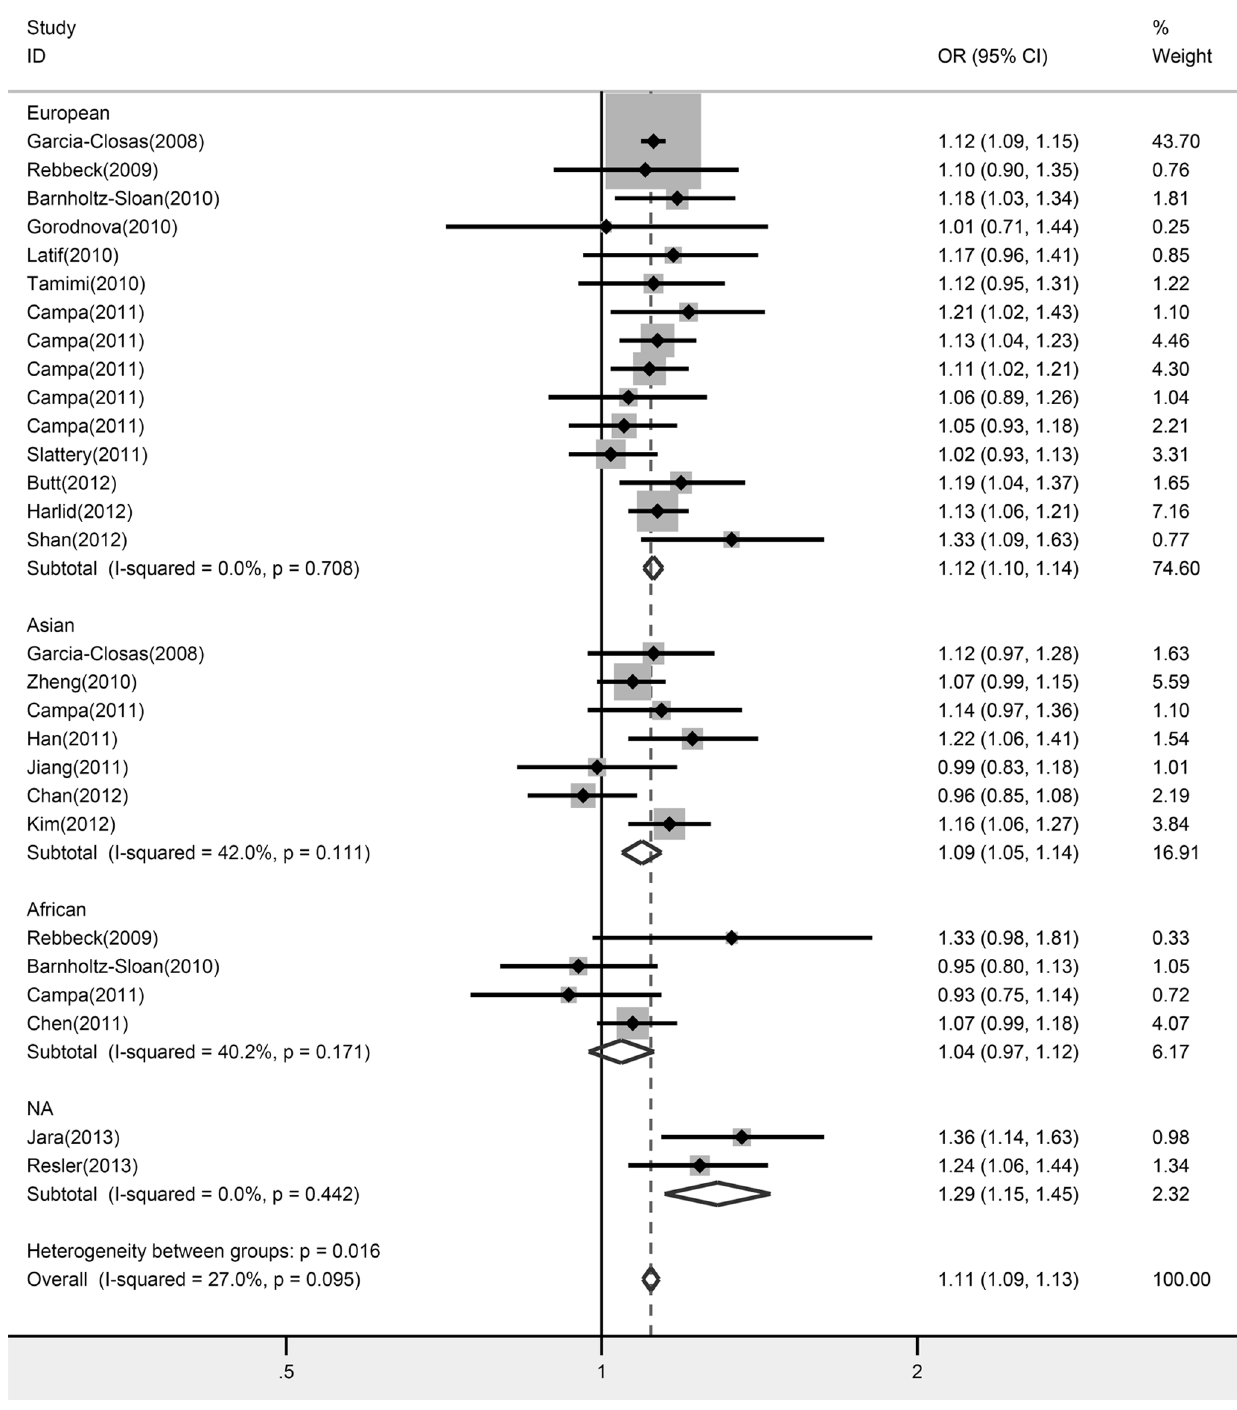
Figure 2. Forest plot of MAP3K1 rs889312 polymorphism and breast cancer risk stratified by ethnicity. Fixed-effect model was used for the analysis (allele contrast model C vs.